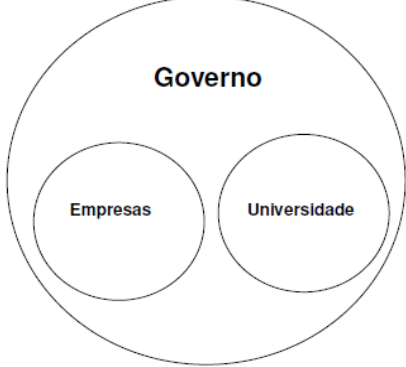
Figura 1. Modelo estático de relações entre universidade-empresa-governo. Fonte: adaptado de Etzkowitz; Leydesdorff (2000). O segundo modelo, a HT2 (Triple Helix